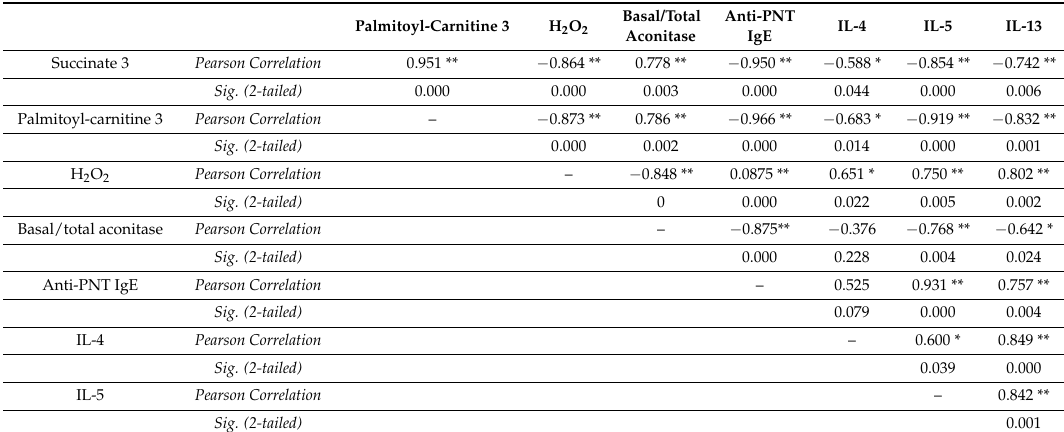
Table 2. Correlation between mitochondrial function markers and Th2